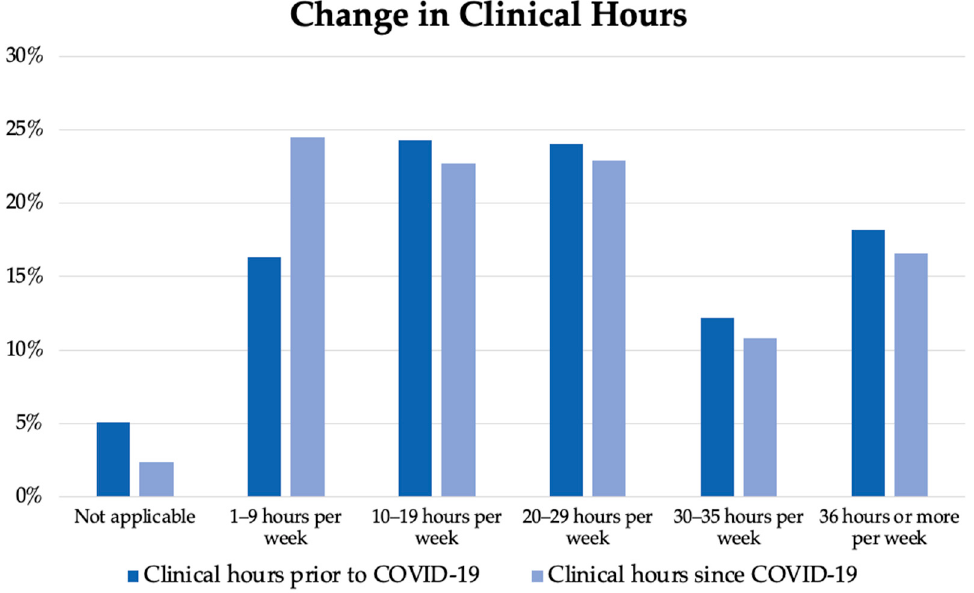
Figure 1. Change in clinical hours prior to and since